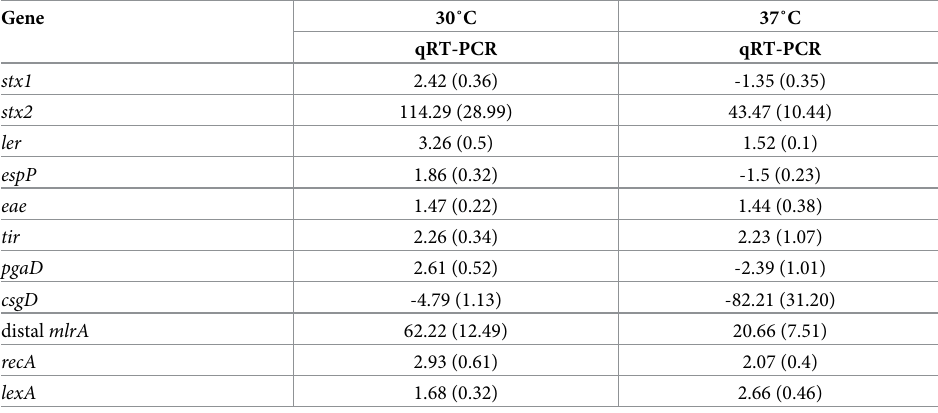
Table 6. Differential FC expression of selected biofilm and virulence genes of strain PA20 grown for 12 hours on T-agar in the presence of 540 μg/L SMX and 108 μg/L TM (27x concentration) at 30˚C and 37˚C. RNA from three independent samples were analyzed by qRT-PCR. Standard deviations are shown in